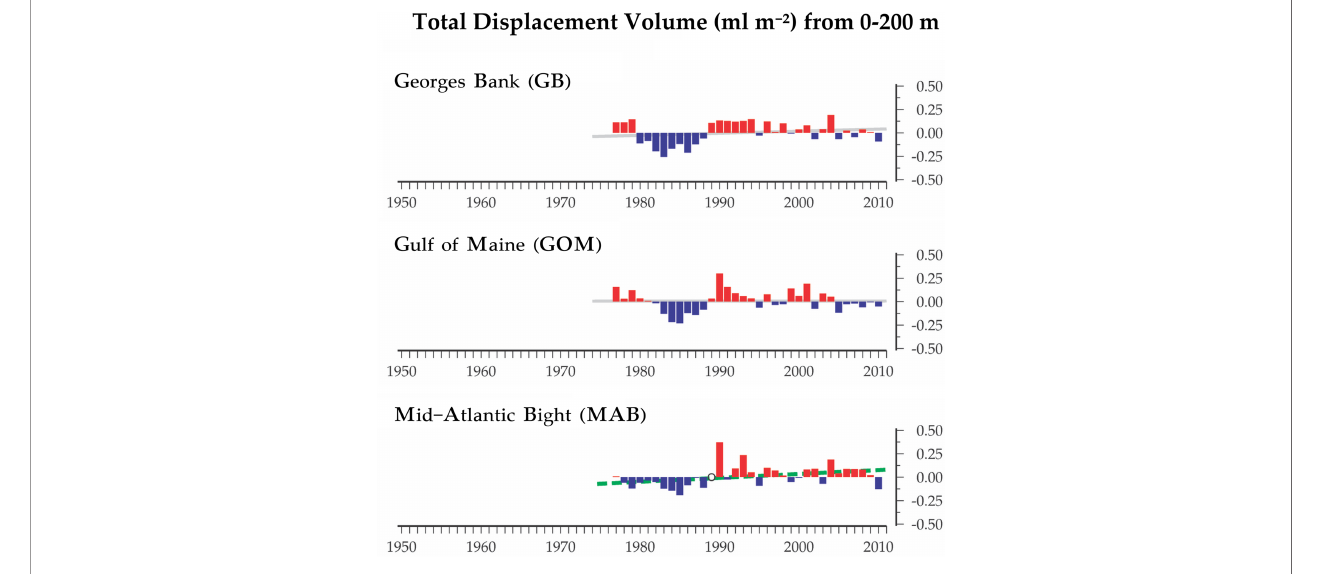
FIGURE 2 | Time-series data for total displacement volume of zooplankton from EcoMon regions: Mid-Atlantic Bight (MAB), Georges Bank (GB), and Gulf of Maine (GoM). Graphs show anomalies based on average values from 1977 to 2010. Positive anomalies are red; negative anomalies are blue. The lines represent the linear regression of the annual anomalies versus year; colors of the lines indicate the statistical signi fi cance of the relationship: dashed green (p < 0.05); grey (non-signi fi cant). Figure modi fi ed from O ’ Brien et al.